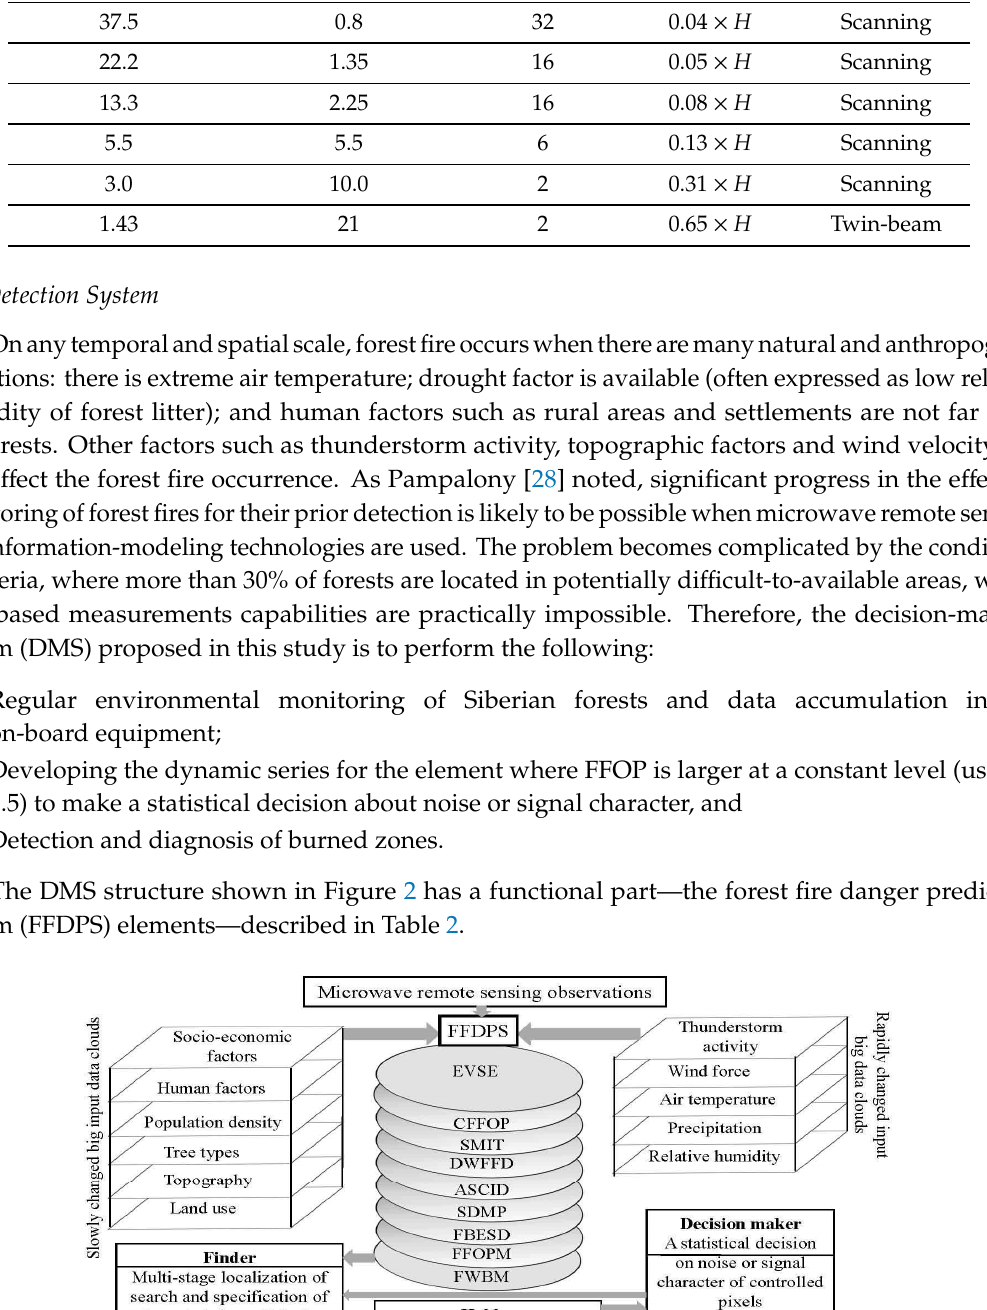
Table 1. Characteristics of the remote sensing sensors which are equipped by the IL-18 platform [26,27].